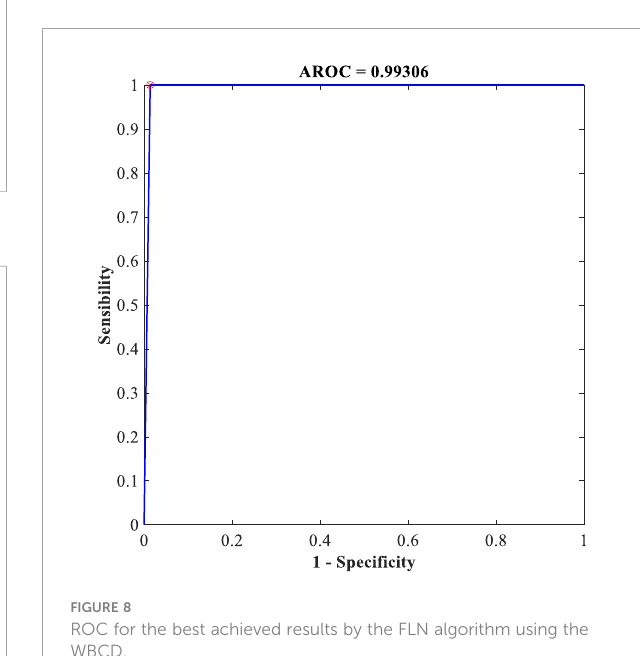
FIGURE 7 Confusion matrix for the best achieved results by the FLN algorithm using the WDBC database.